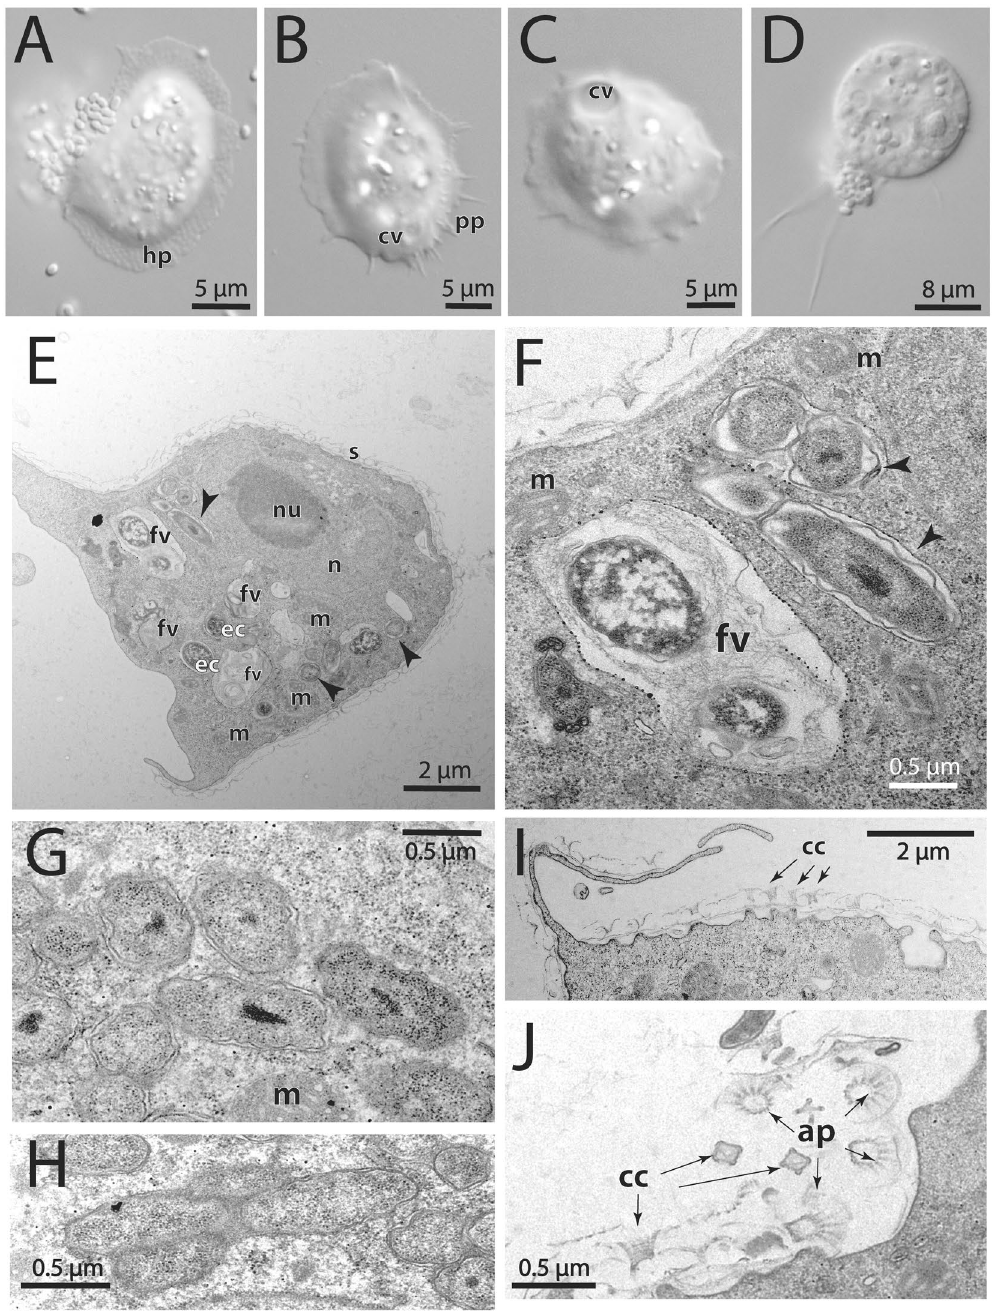
Figure 1. Intracellular location and morphology of ‘ Candidatus Cochliophilus cryoturris’ PDD8 in Cochliopodium minus 9B. ( A – C ) Lightmicrographs of Cochliopodium minus trophozoites with the characteristic scaled hyaloplasm (hp); the contractile vacuole (cv) involved in osmoregulation and subpseudopodia (pp) are readily visible. ( D ) Early stage of the encystation process showing the onset of cytoplasm condensation. ( E ) Electronmicrograph of a trophozoite containing several C. cryoturris symbionts (arrow heads) and food vacuoles (fv) with E. coli (ec; note the evidence for degradation). The host nucleus (n), the nucleolus (nu), and the dorsal scale cover (s) can be recognized. ( F – H ) C. cryoturris is located in membrane-bound compartments (arrow heads); the bacteria show a Gram-negative type cell envelope, with a partially widened periplasmic space; an electron-dense central area indicating condensed cytoplasmic components is present in many of the symbionts; mitochondria (m) can be seen in the vicinity of symbiont-containing vacuoles. ( I ) The characteristic scales of the Cochliopodium minus host are shown in a cross section including the funnel-shaped central column (cc). ( J ) The apical part (ap) of the scales as well as vertical and tangential sections of central columns (cc) are